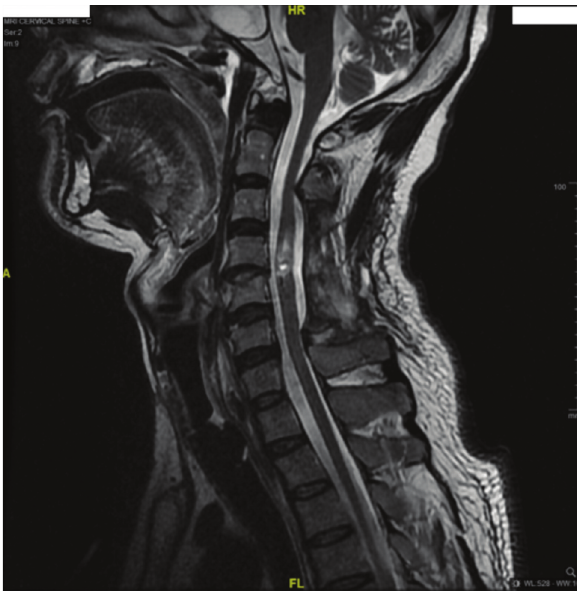
Another MRI of cervical and thoracic spine at day 34 post Fig. 2: injury showed an increased T2 weighted signal from C4 to C5 with